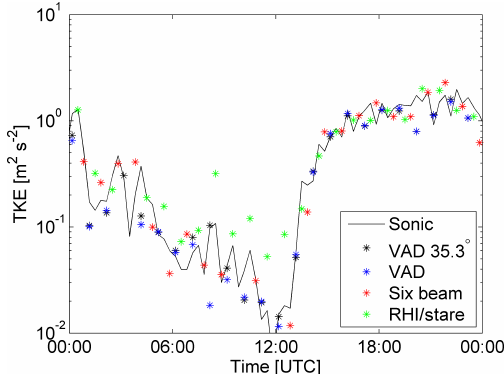
Figure 3. Satellite imagery of the BAO site with the locations of the 300m tower and Doppler lidar deployment indicated. Figure 4. Sample time series of measured TKE on 30 May 2015 at